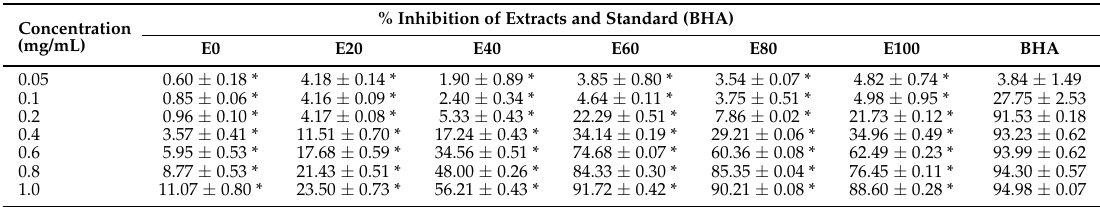
Table 5. Percentage inhibition determined using the DPPH assay.